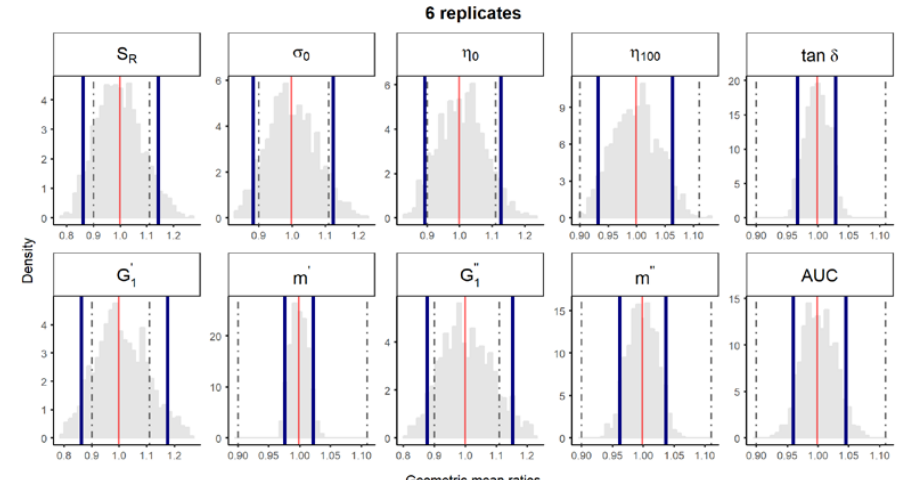
Figure S4. Bootstrap analysis of rheological parameters using 6 replicates—5 reference batches versus 5 references batches. A total of 10,000 geometric mean ratios (light grey area) resulting from the bootstrap analysis of “5 reference batches versus 5 test batches” for each rheological parameter. Data of 10 batches and 6 replicate each were used. Median (solid red line) and non-parametric 90% CI (solid blue lines) of the probability distribution. Dashed lines represent the acceptance limits for equivalence (90%–111.11%) stated in the EMA guideline [4]. S R , relative thixotropic area; σ 0 , yield stress; η 0 , zero-shear viscosity; η 100 , viscosity at 100 s −1 ; tan δ , loss tangent at 1 Hz; , calculated elastic modulus; G (cid:48)(cid:48) , calculated viscous modulus; m’ and m ” are the parameters obtained when fitting G’ and G” , respectively, versus frequency; AUC , area under the weight versus surface curve (spreadability).